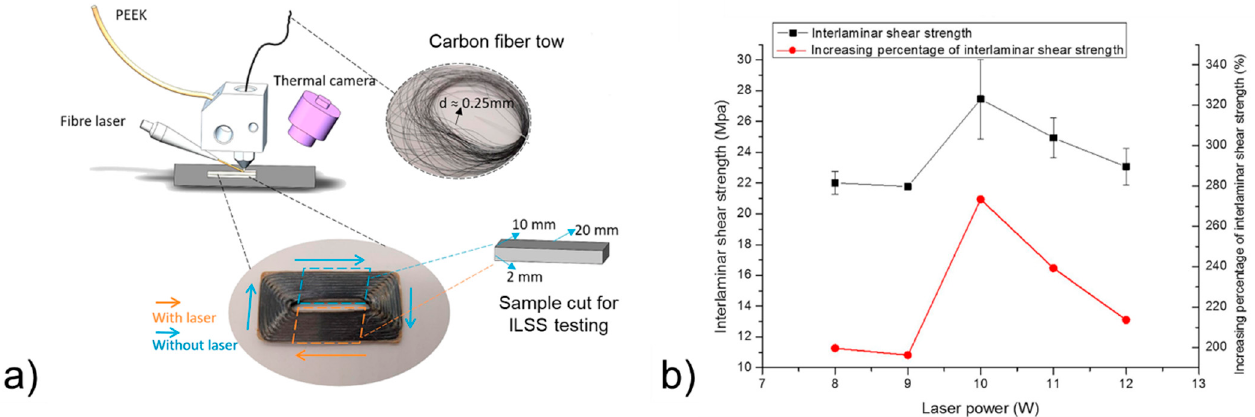
Figure 6. Laser-assisted printing process [21]: ( a ) diagram of the preparation of continuous CF/PEEK composite samples for ILSS testing and ( b ) ILSS and increasing percentage of ILSS with different laser powers (copyright (2019) with permission from Elsevier).